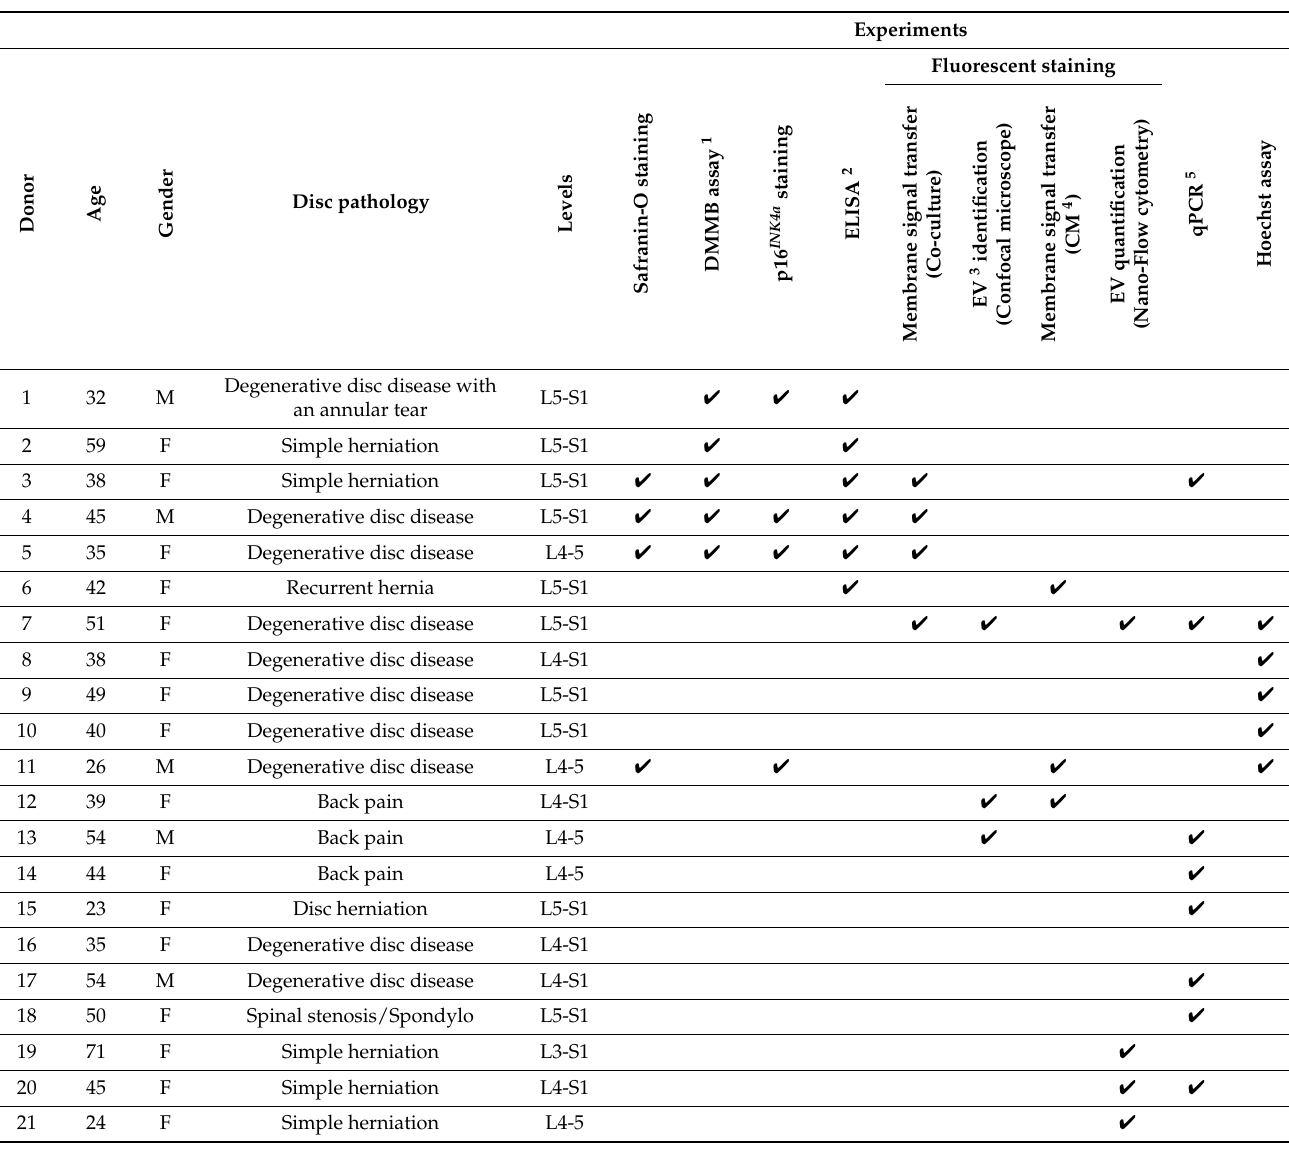
Table 1. Patient information and applications.